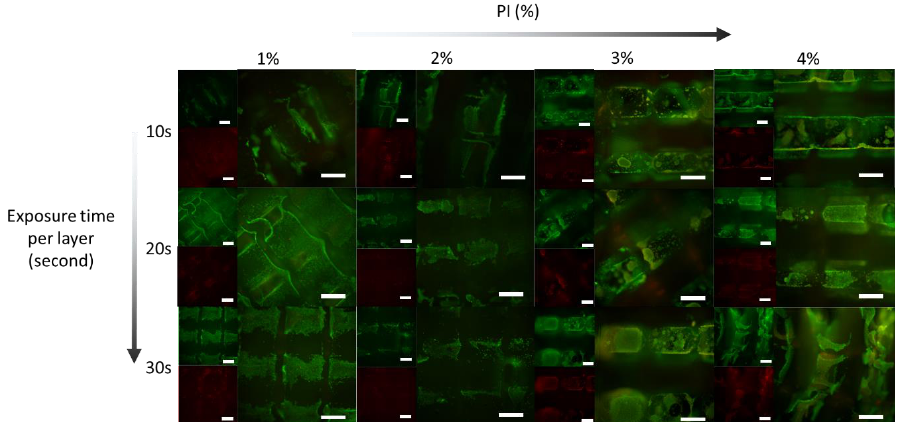
Figure 5. Fluorescence images of L929 fibroblasts on 3% TMPTA, N80-D15-A5 scaffolds (37 ◦ C) at different photo-initiator ratios (horizontal) and exposure times (vertical) after live/dead staining at day 7. In each group, one small picture shows the fluorescence channel for calcein (green) and another the fluorescence wavelength for ethidium homodimer (red). The large picture in each group shows an overlay of both channels. Scale bars represent 500 µm.